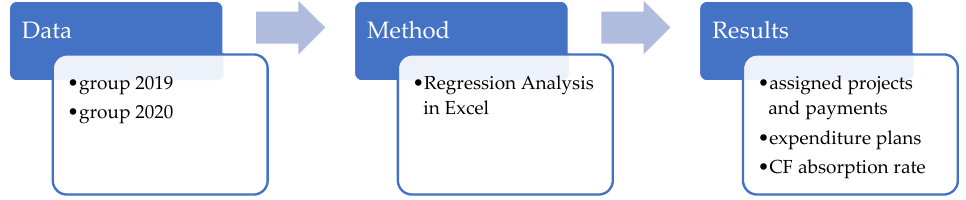
Figure 1. Methodology flow